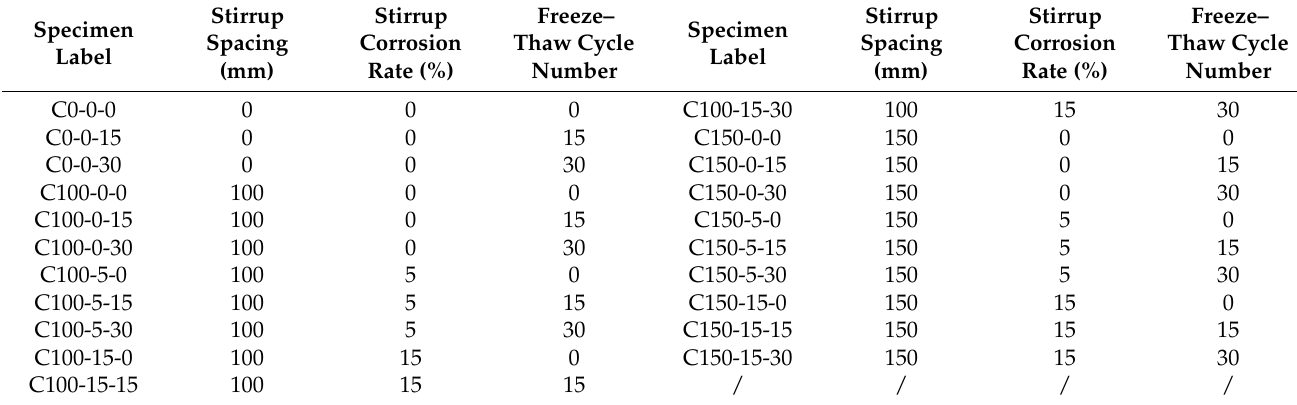
Figure 1. Test specimen (mm): ( a ) Different stirrup arrangement; ( b ) Cross-section front. Table 1. Corrosion grade of stirrups, stirrup spacing and freeze–thaw cycles of tested specimens.